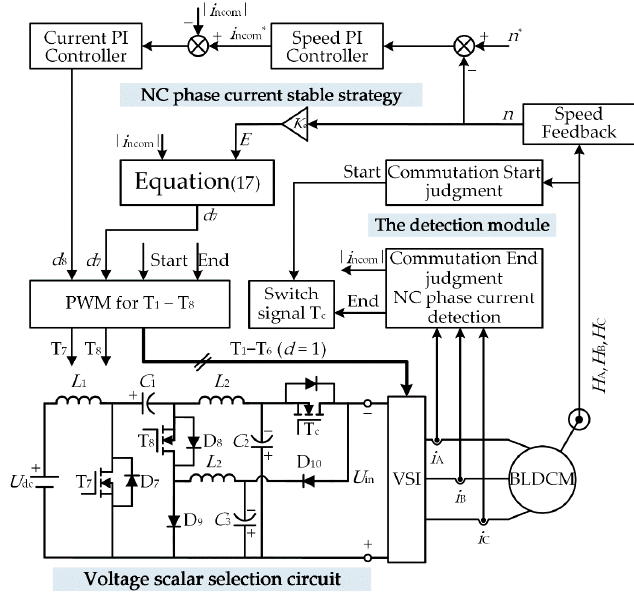
Figure 6. The proposed commutation torque ripple reduction strategy.